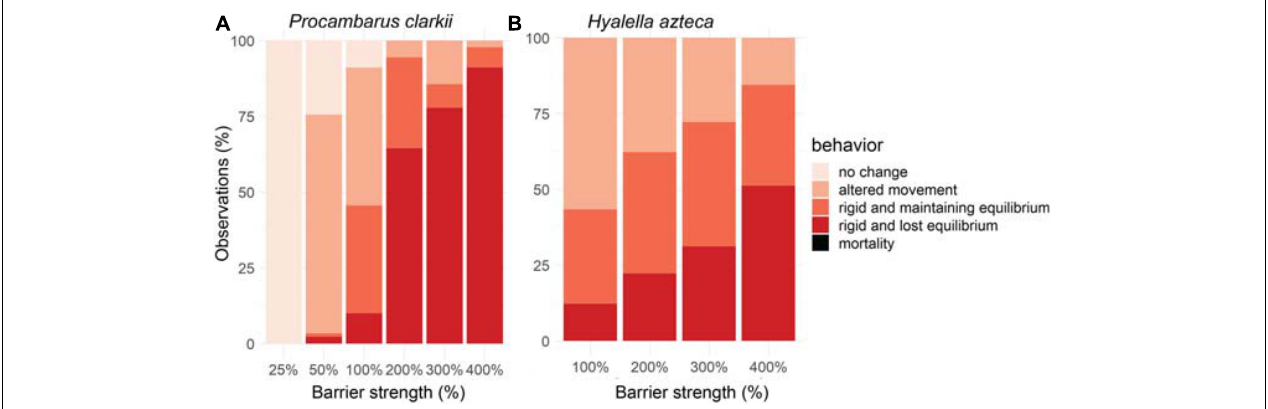
FIGURE 2 | Aggregated behavior across time during 5 min of stimulus phase for (A) juvenile Procambarus clarkii ( n = 15 for each barrier strength) for 25%, 50%, 100%, 200%, 300%, and 400% of existing barrier strength; and (B) Hyalella azteca ( n = 15 for each barrier strength) for 100%, 200%, 300%, and 400% of existing barrier